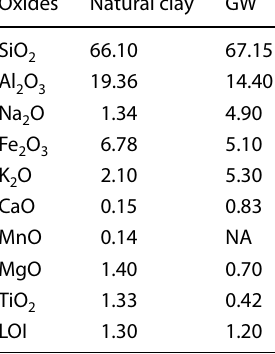
Table 1 Mixed raw materials compositions in (wt%) Formulation Raw materials Granite powder